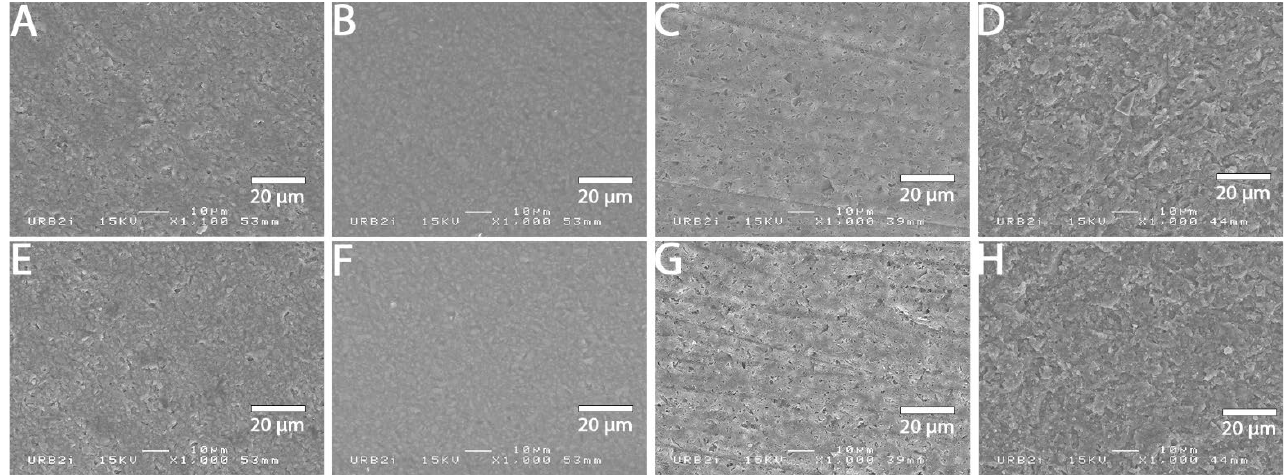
Figure 3. SEM micrograph for Grandio block surface (×1000 magnification) with the different surface treatments: ( A ) control; ( B ) polyacrylic acid; ( C ) hydrofluoric acid; ( D ) sandblasting; ( E ) 800 grit polishing + universal primer; ( F ) polyacrylic acid + universal primer; ( G ) hydrofluoric acid + universal primer; ( H ) sandblasting + universal primer. Sandblasting surface treatment ( D , H ) shows a deeper and more irregular pattern surface than the other ones.